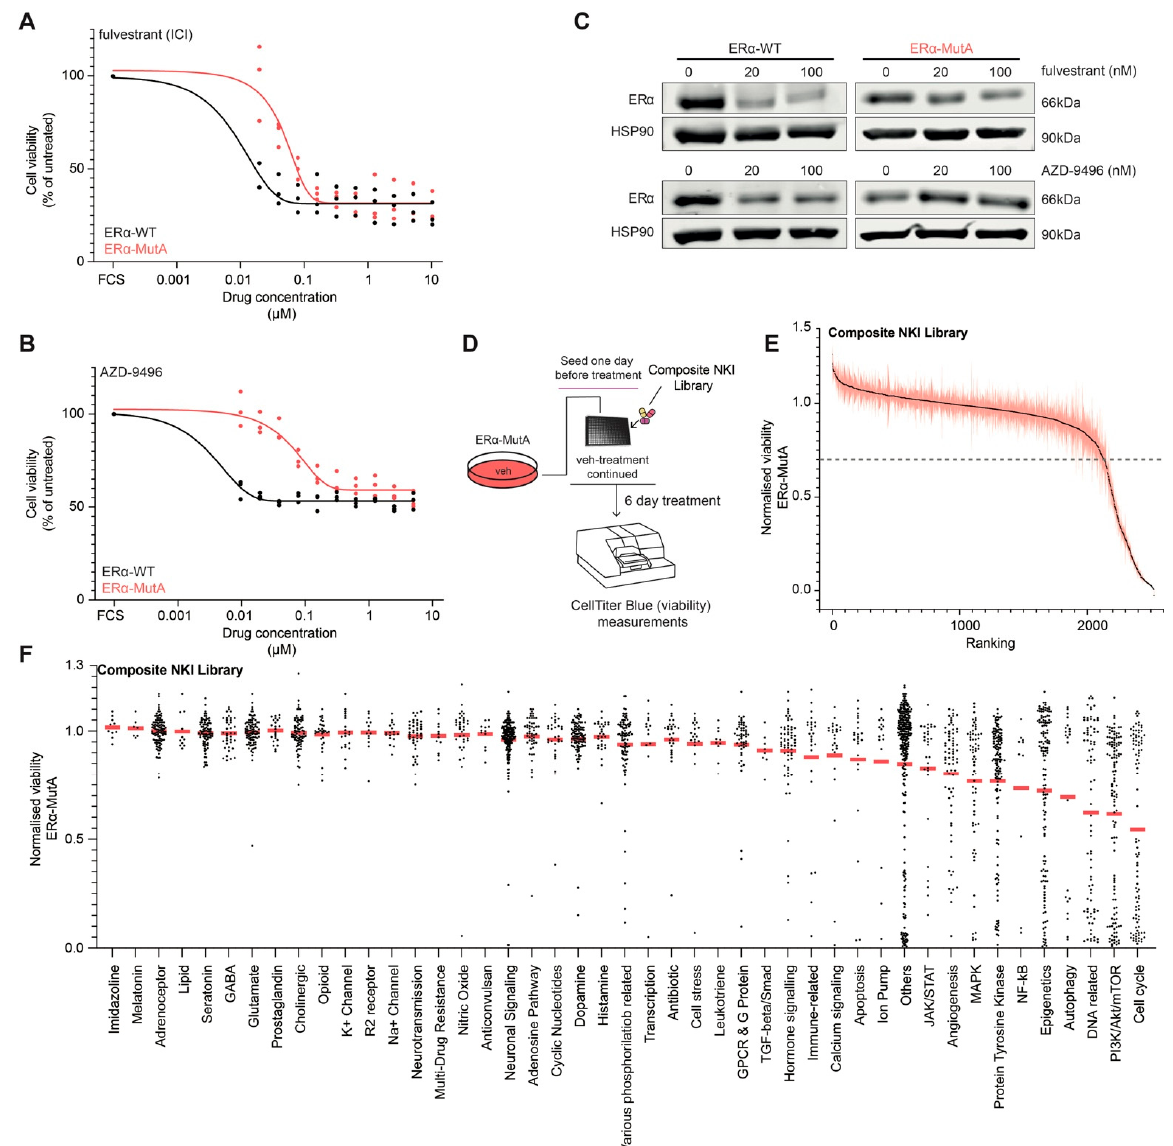
Figure 1. ER α mutant cells are sensitive to various inhibitors of the cell cycle. ( A ) ER α -MutA and ER α -WT cells were cultured with ER degrader fulvestrant. After six days, cell viability was measured using CellTiter-Glo. Full circles depicted independent replicate ( n = 3) values, while the lines represent the curve fitting for sigmoidal (4PL) model (black, ER α -WT; red, ER α -MutA). ( B ) ER α -MutA and ER α -WT cells were cultured with ER α degrader AZD-9496. After six days, cell viability was measured using CellTiter-Glo. Full circles depicted independent replicate ( n = 3) values, while the lines represent the curve fitting for sigmoidal (4PL) model (black, ER α -WT; red, ER α -MutA). ( C ) Representative western blot showing expression of ER α in ER α -MutA and ER α -WT cell lines treated with 20 nM and 100 nM fulvestrant or AZD-9496 for 24 and 48 h, respectively. Hsp90 was used as loading control ( n = 3). ( D ) Schematic representation of the drug screen: ER α -MutA cells were seeded and cultured in full medium. On the following day, the drugs from the library were added at the concentration of 1 µ M. After six-day treatment, CellTiter Blue assay was performed and viability measured using fluorescence reader. ( E ) Ranked plot showing viability of ER α -MutA cells following a six-day with 1 µ M of the library compounds. Drugs that reduce the viability below 0.7 are considered effective. Black dots and red shade around these represent the mean viability and SD per compound, respectively ( n = 3). ( F ) Normalized viability per compound category of the drug screen in ER α -MutA cells. Red line represents the mean viability per category, and black dots represent viability value for each of the compounds ( n = 3). Figures S5 and S6 contain the western blot original material including uncropped blot images and densitometry readings/intensity ratio of western blot bands,